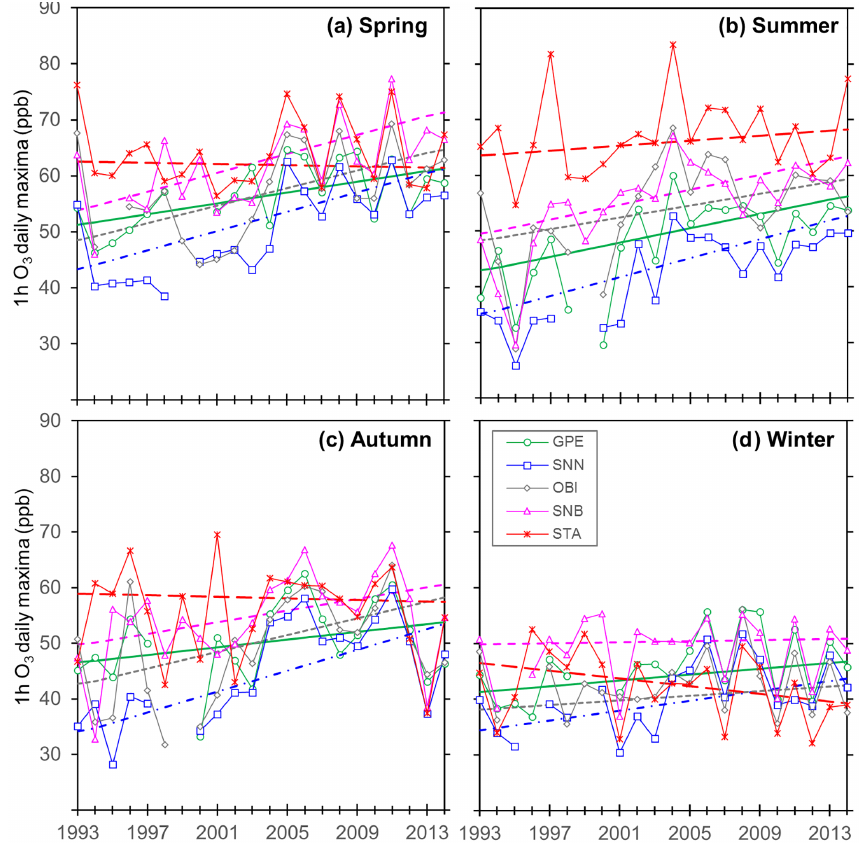
Figure 12. Seasonal trends in 1h O 3 daily maxima at the MMA during 1993–2014. Each data point represents the average of the 3-month period that defines the season. The dashed lines show the Sen